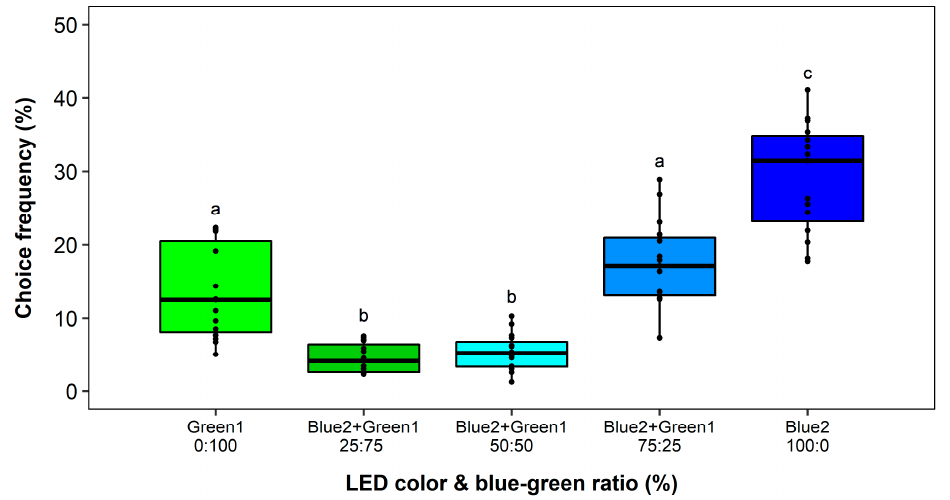
Figure 10. Wavelength preferences of Frankliniella occidentalis in multiple-choice experiment with blue and green light-emitting diodes (LEDs) and respective combinations with different intensity ratios. See Table 1 and Figure 2 for LED specifications. Significant differences are indicated by different letters (generalized linear model, Tukey test, p < 0.05, n = 15).